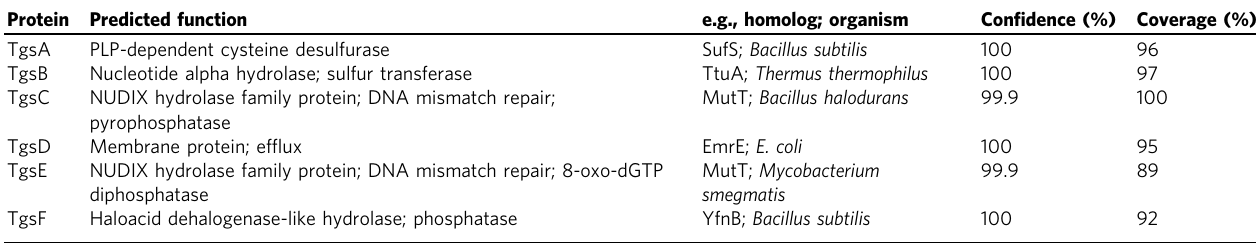
Table 1 Putative function of gene products in the S. chromogenes 6-TG biosynthetic cluster. Protein Predicted function e.g., homolog; organism Con fi dence (%) Coverage (%) TgsA PLP-dependent cysteine desulfurase SufS; Bacillus subtilis 100 96 TgsB Nucleotide alpha hydrolase; sulfur transferase TtuA; Thermus thermophilus 100 97 TgsC NUDIX hydrolase family protein; DNA mismatch repair; MutT; Bacillus halodurans 99.9 100 pyrophosphatase TgsD Membrane protein; ef fl ux EmrE; E. coli 100 95 TgsE NUDIX hydrolase family protein; DNA mismatch repair; 8-oxo-dGTP MutT; Mycobacterium 99.9 89 diphosphatase smegmatis TgsF Haloacid dehalogenase-like hydrolase; phosphatase YfnB; Bacillus subtilis 100 92 Phyre 2 , the protein homology/analogy Recognition Engine v.2.0, web portal was used to search the protein structure databases for predicting protein structure and function.